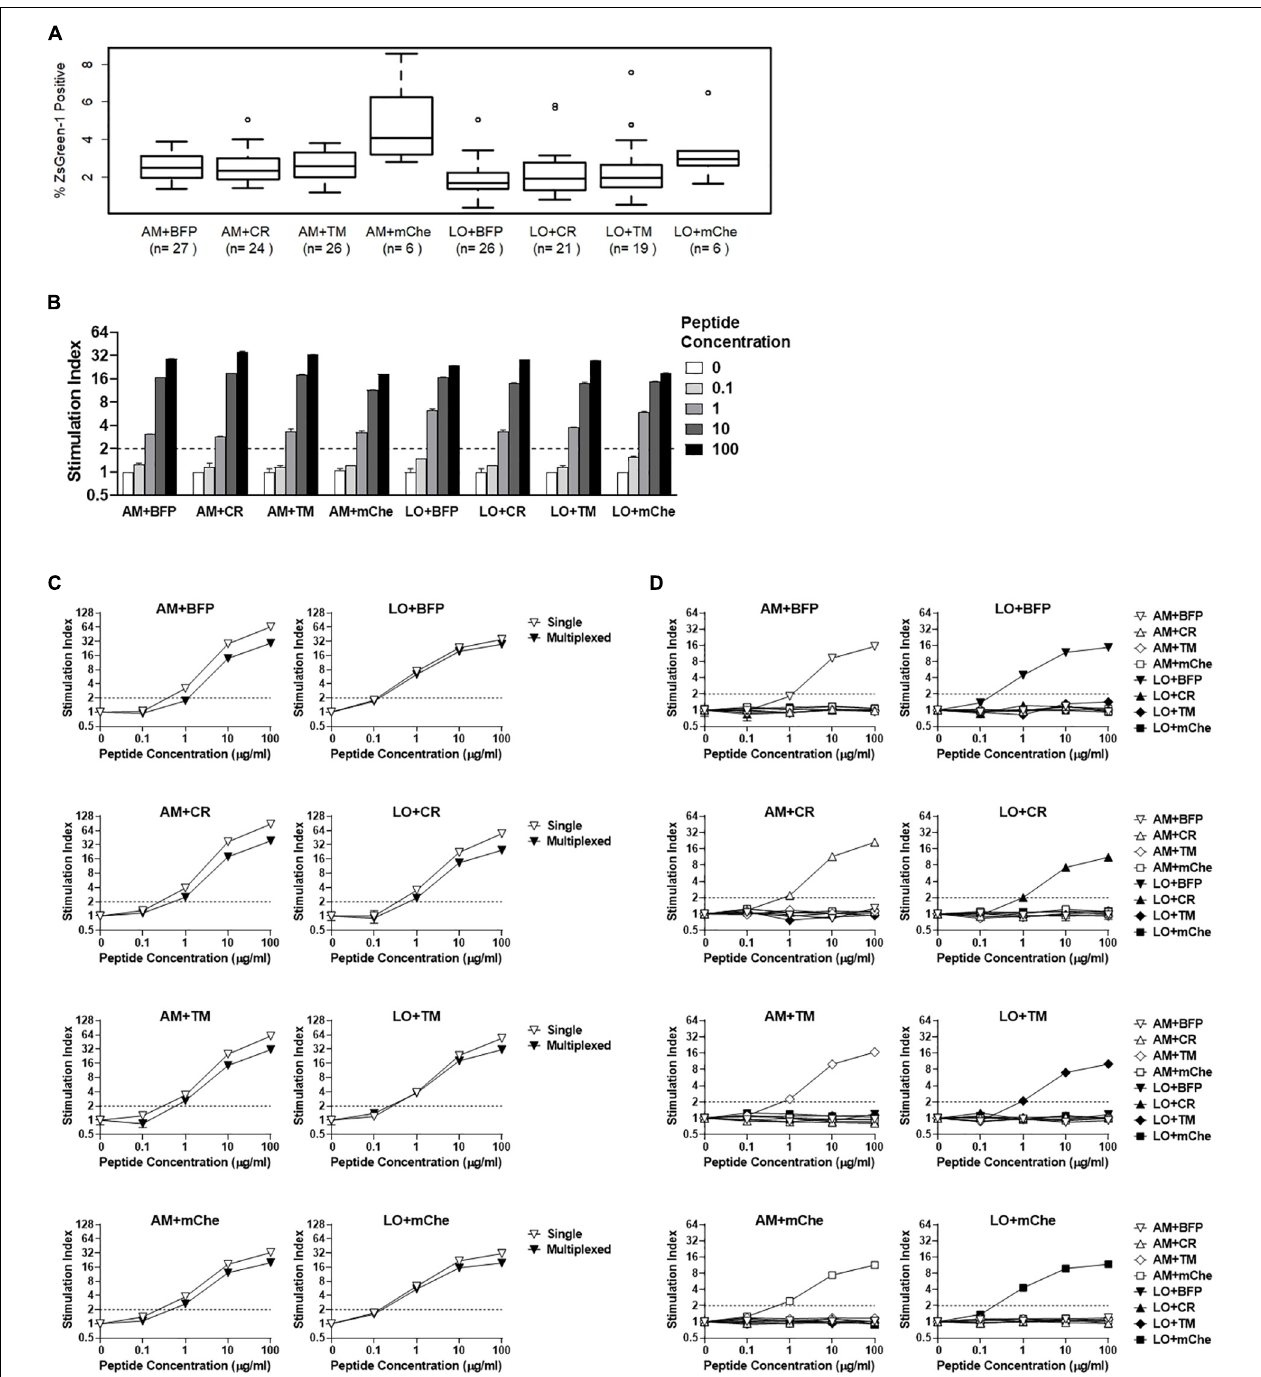
FIGURE 5 | Addition of fluorochrome identifiers and multiplexing. (A) ZsGreen-1 positivity of unstimulated cells expressing TCRs with different fluorochrome combinations. Each 5KC T-hybridoma cell line expresses a single unique TCRs along with one of eight different fluorochrome combinations. 5KC T-hybridoma cells were cultured overnight in the presence of autologous B cells transformed with Epstein-Barr virus. Frequency of ZsGreen-1-positive 5KC T-hybridoma cells expressing eight different fluorochrome combinations was determined by flow cytometry using the gating strategy shown in Supplementary Figure S2 and were compared using one-way ANOVA and Tukey’s Honestly Significant Difference (Tukey’s HSD). Numbers of TCRs that are included for each fluorochrome combination are shown in parenthesis. T-hybridoma cells expressing ametrine and mCherry (AM+mChe) have significantly higher ZsGreen-1 positivity compared to T-hybridomas expressing all other fluorochrome combinations except LO+CR (Turkey’s p = 0.001 in AM+mChe vs. AM+BFP, AM+CR, AM+TM, and Turkey’s p < 0.001 in AM+mChe vs. LO+BFP, LO+CR, LO+TM). (B) 1E6 TCR T-hybridoma cells expressing eight different fluorochrome combinations were unstimulated or